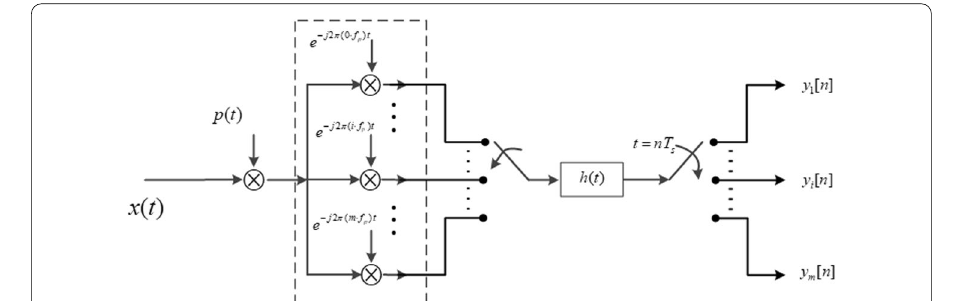
Fig. 3 Frequency shifting module with parallel structure